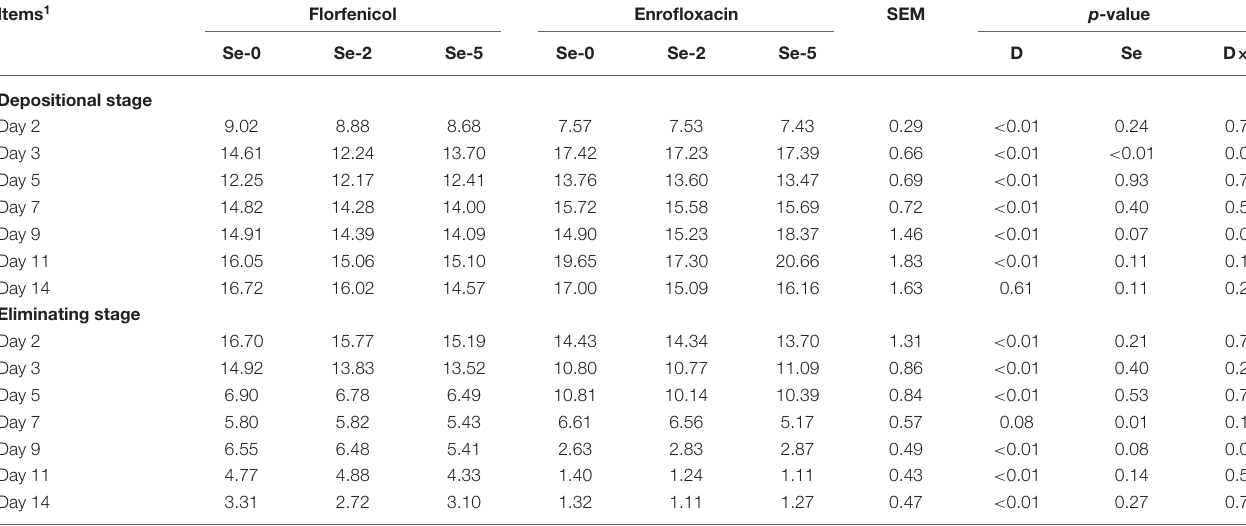
TABLE 5 | Effects of dietary organic selenium on residue of drugs in liver of laying hens. Items